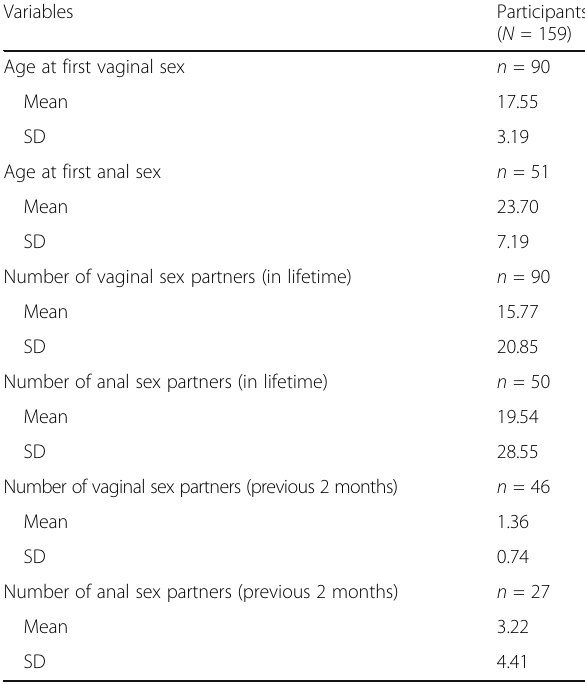
Table 3 Means and standard deviations in sexual behaviors Variables Participants